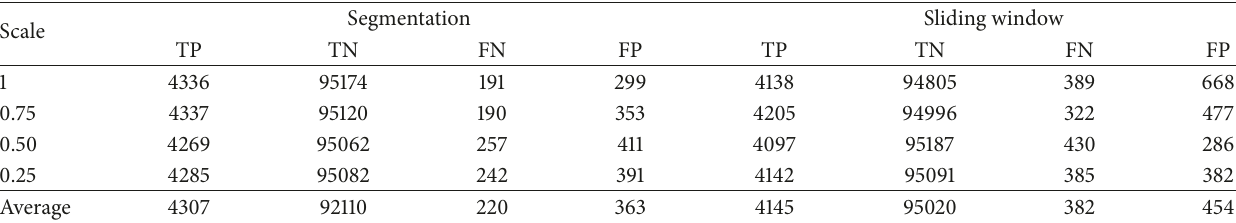
Table 2: Confusion matrix results.